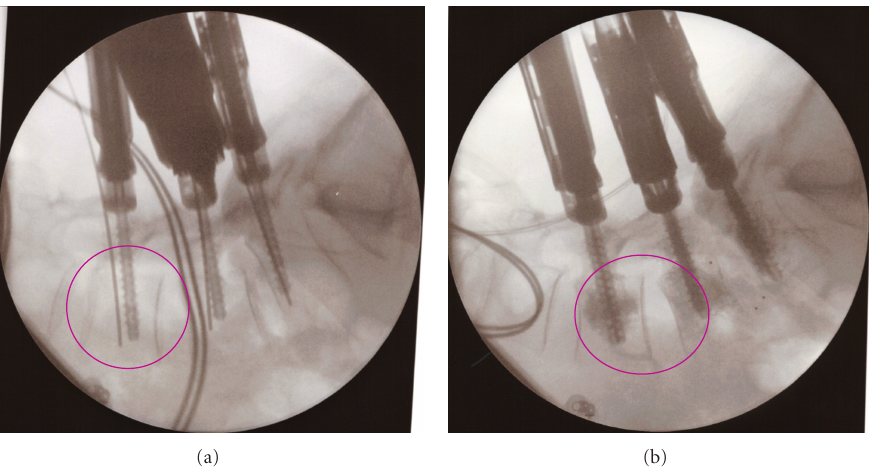
Figure 6: Injection must be done under fluoroscopic control to immediately stop the injection in case of cement extravasation.